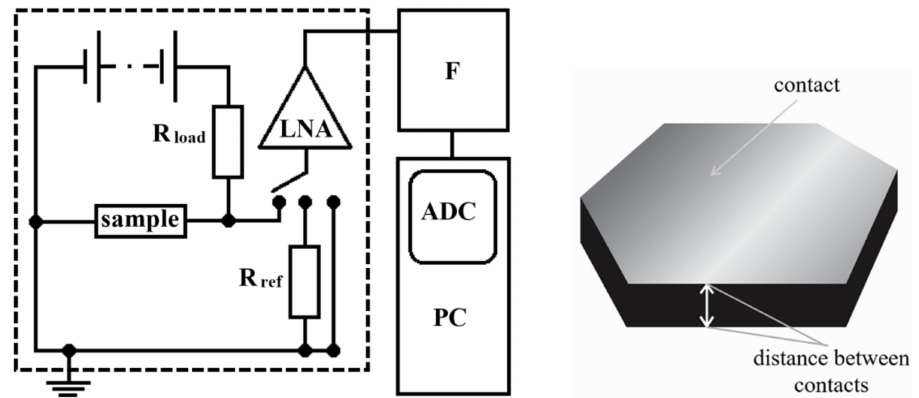
Figure 2. Scheme of the noise measuring system (on the left): low noise amplifier (LNA), filter system (F), analog-to-digital converter (ADC), personal computer (PC) and schematic picture of the sample (on the